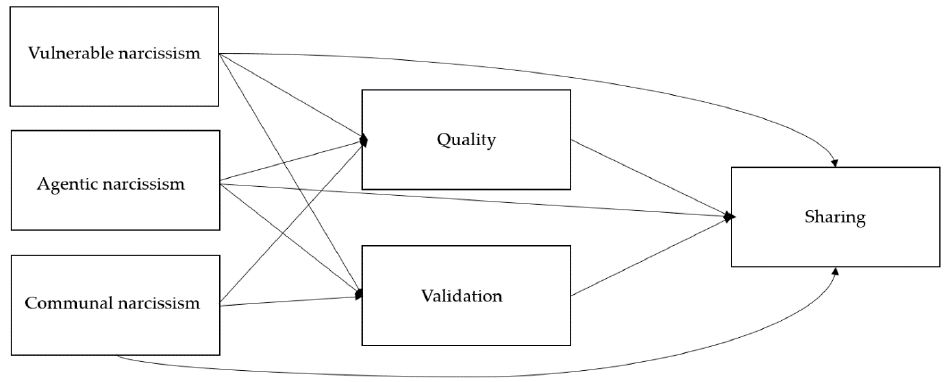
Figure 1. Hypothesized model of relationships between narcissism and social media behaviors and motives.